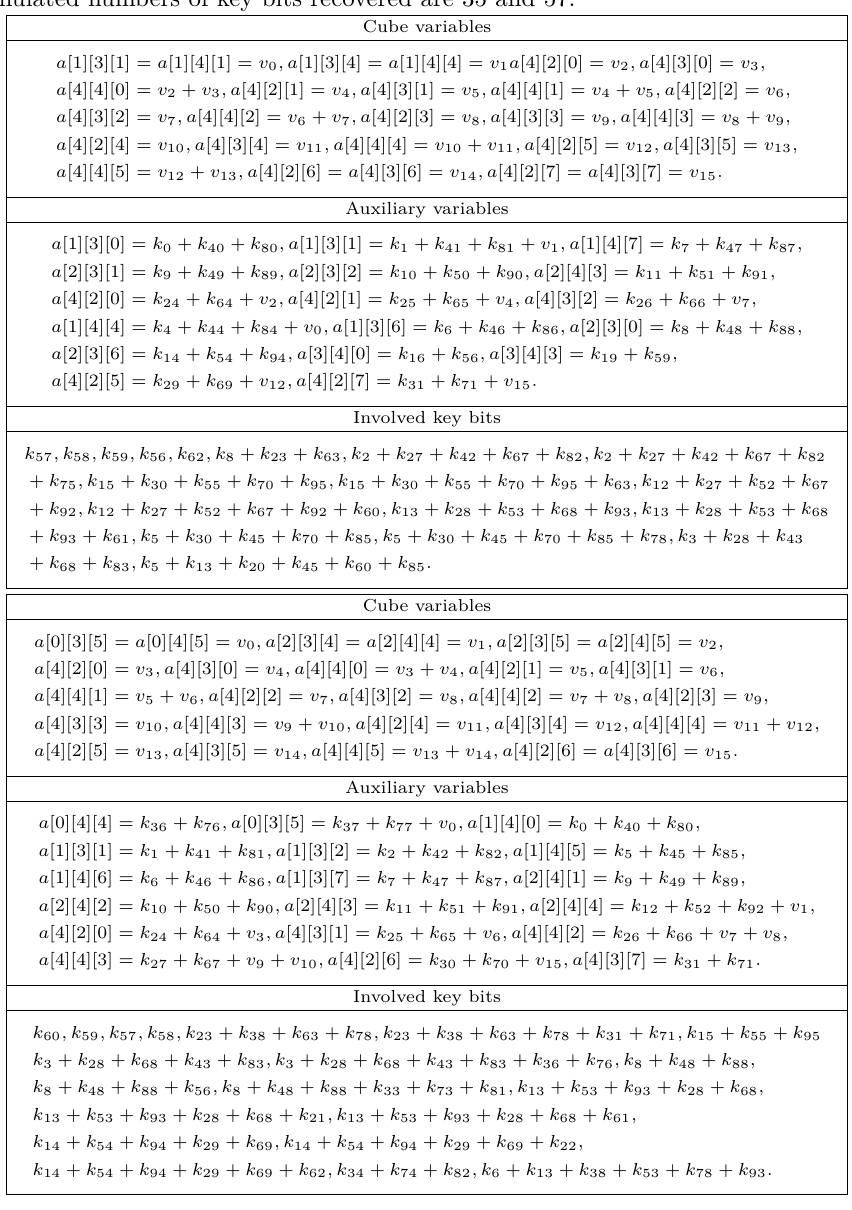
, n 0 ) are (17 , 18) and (9 , 14), respectively. The a i